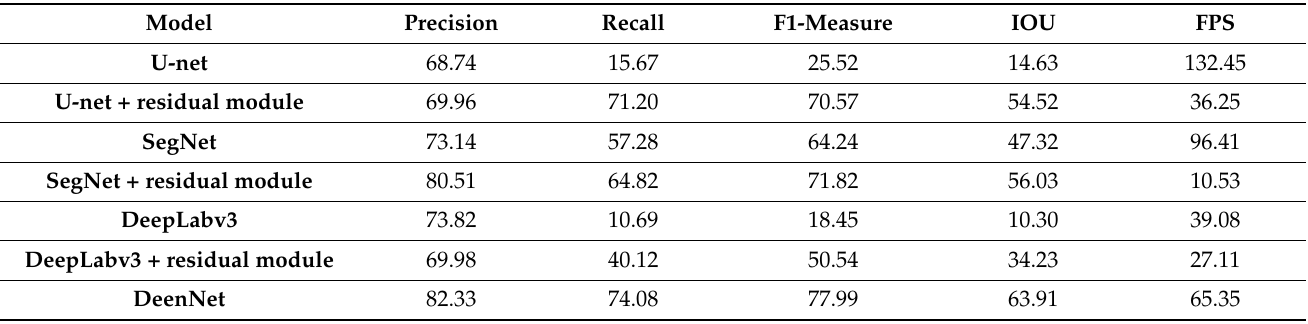
Table 4. Statistics used to assess the performance of the models in terms of landslide detection on the Jiuzhaigou landslide dataset